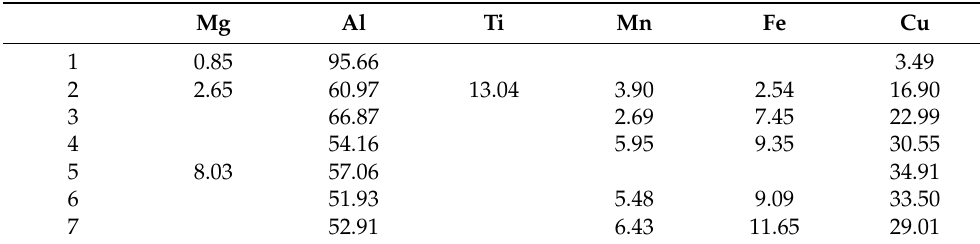
Table 3. The EDS results of solid-solution microstructure